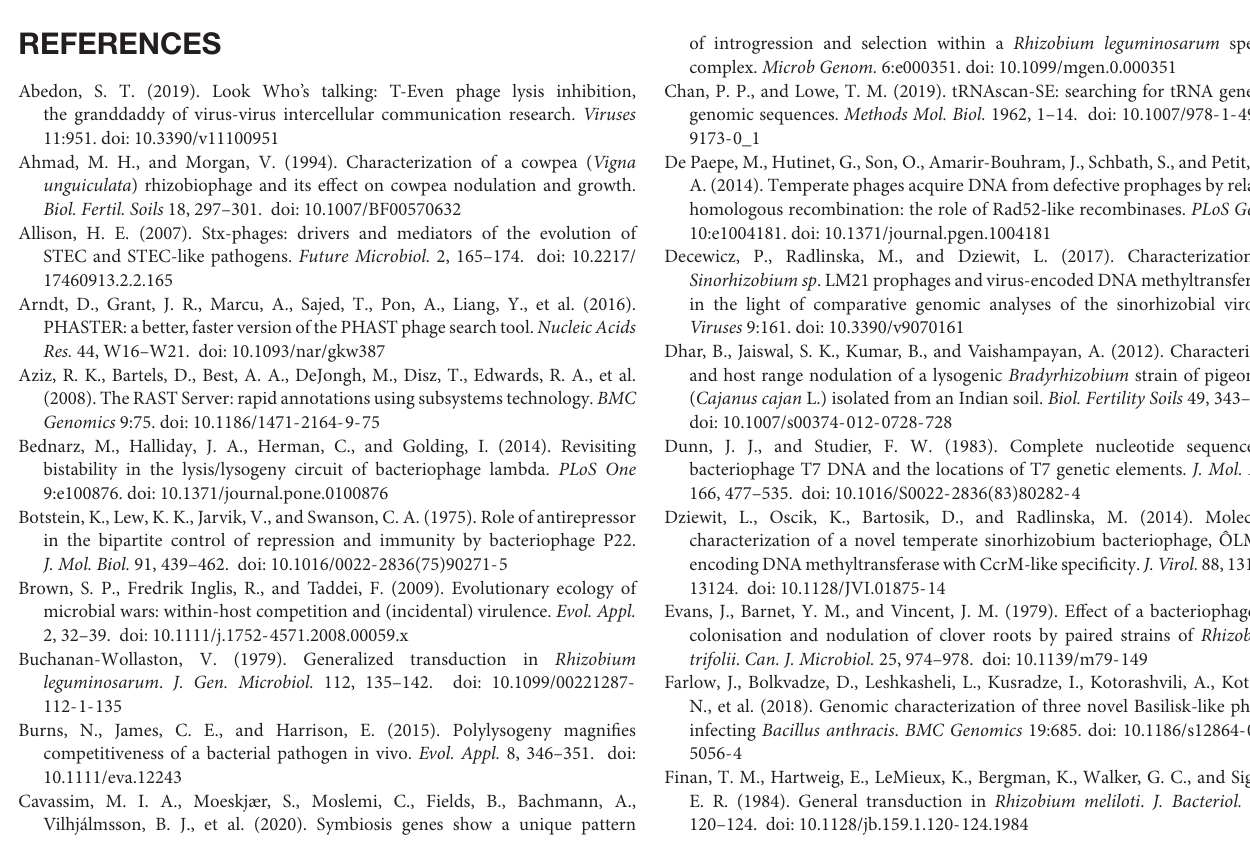
the top right show ANI values for whole phage genomes with intensity of color denoting intergenomic similarity. Squares in the bottom left half show the genome length ratio (numbered) and the proportion of sequence aligned for each comparison (shading). Highlighted squares represent the 5 phages isolated from Rhizobium leguminosarum (green box) and the phages which share > 70% ANI, and are therefore likely members of the Paadmavirus genus (pink). Supplementary Figure 2 | Illustrating the integration of the vTRX32-1 like phages into the Rhizobium genome (based on genome comparisons of vTRX32-1 and vRHEph01 with closely related prophage). The tRNA-Leu in the Rhizobium genome contains a 12 bp motif also carried by the phage (red), this acts as the region of homology (attB/attP site) for phage integration. In the process of integration the bacterial tRNA-Leu (yellow) is interrupted and replaced by a phage encoded tRNA-Leu (yellow, hashed) in the phage genome. Supplementary Figure 3 | Percent identity between amino acid sequences predicted by RAST in the vTRX32-1 genome and those of related phage/prophage. Genes ( X -axis) are ordered from the highest percent identity (left) to the lowest (right), phage/prophage genomes ( Y -axis) are ordered similarly from top to bottom. Colored highlights adjacent to gene names indicate predicted class membership (yellow = early/class I, blue = middle/class II, red = late/class III). Pairwise blastP was used to generate percent identity values and only hits with an E -value less than 1E-4 were included. Supplementary Table 1 | Details of phages and putative phages identified as related to vTRX32-1. Supplementary Table 2 | Annotated data sets from the 3 phenotypic assays; phage virulence, phage replication dynamics (one step growth curve) and host range. Details are included in each